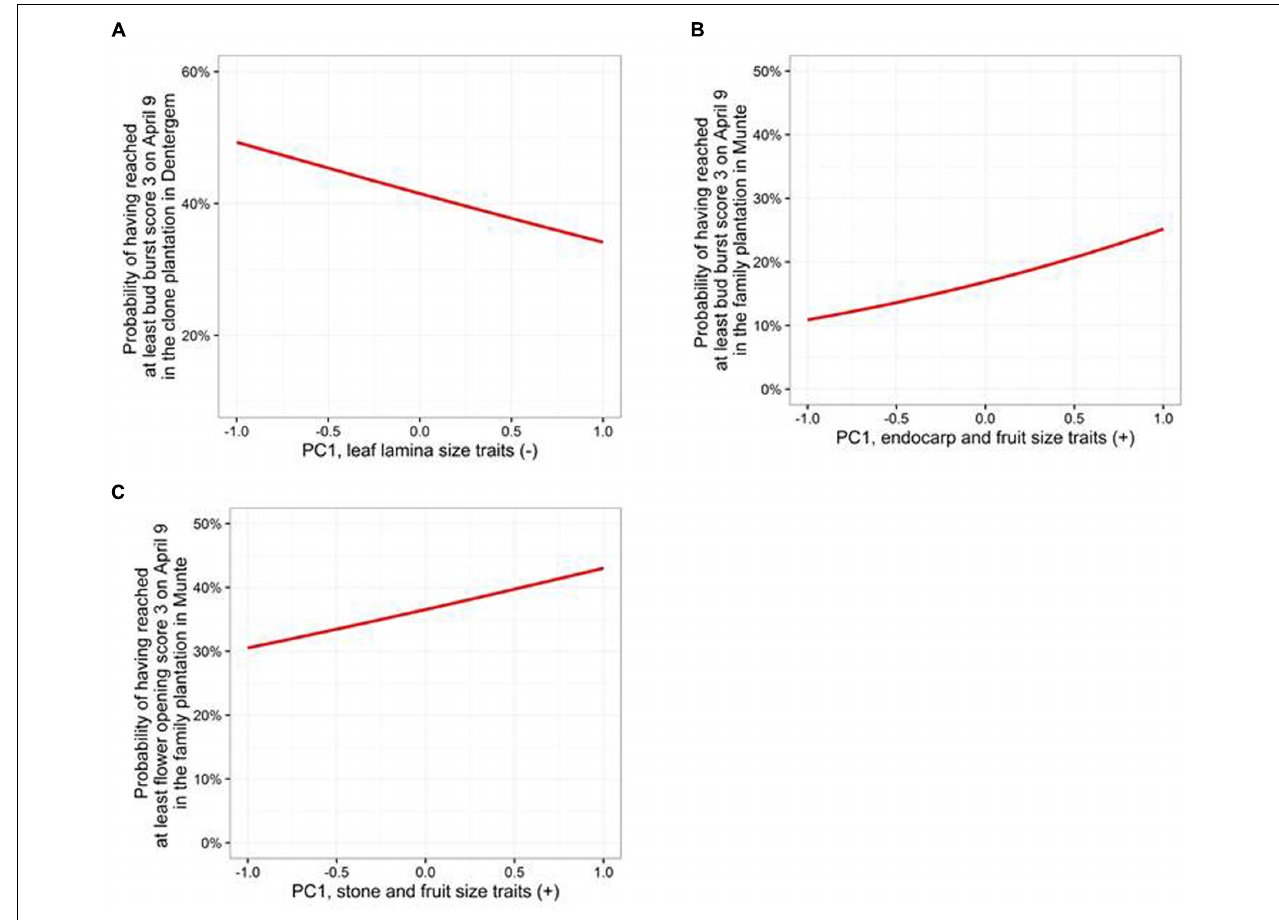
FIGURE 8 | Modeled probability of having reached a given phenological score level according to the first principal component axis in the clone and family plantations. (A) Bud burst in the clone plantation in Dentergem. (B) Bud burst in the family plantation in Munte. (C) Flower opening in the family plantation in Munte. All probabilities were calculated based on the covariates PC2 = 0 and PC3 =